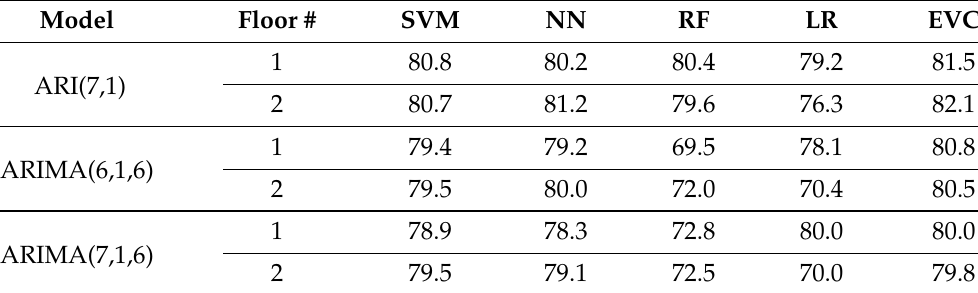
Table 7. Accuracy (%) of the local damage pattern recognition for different candidate models.